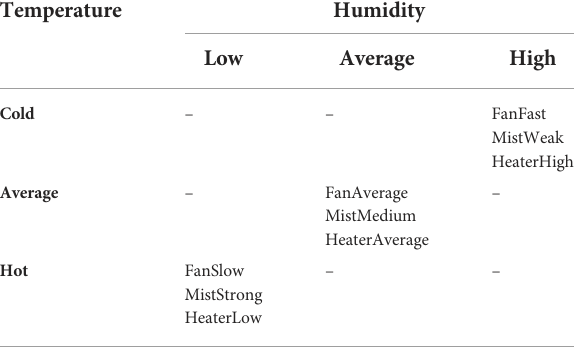
TABLE 1 Fuzzy associative matrix (Group 1).